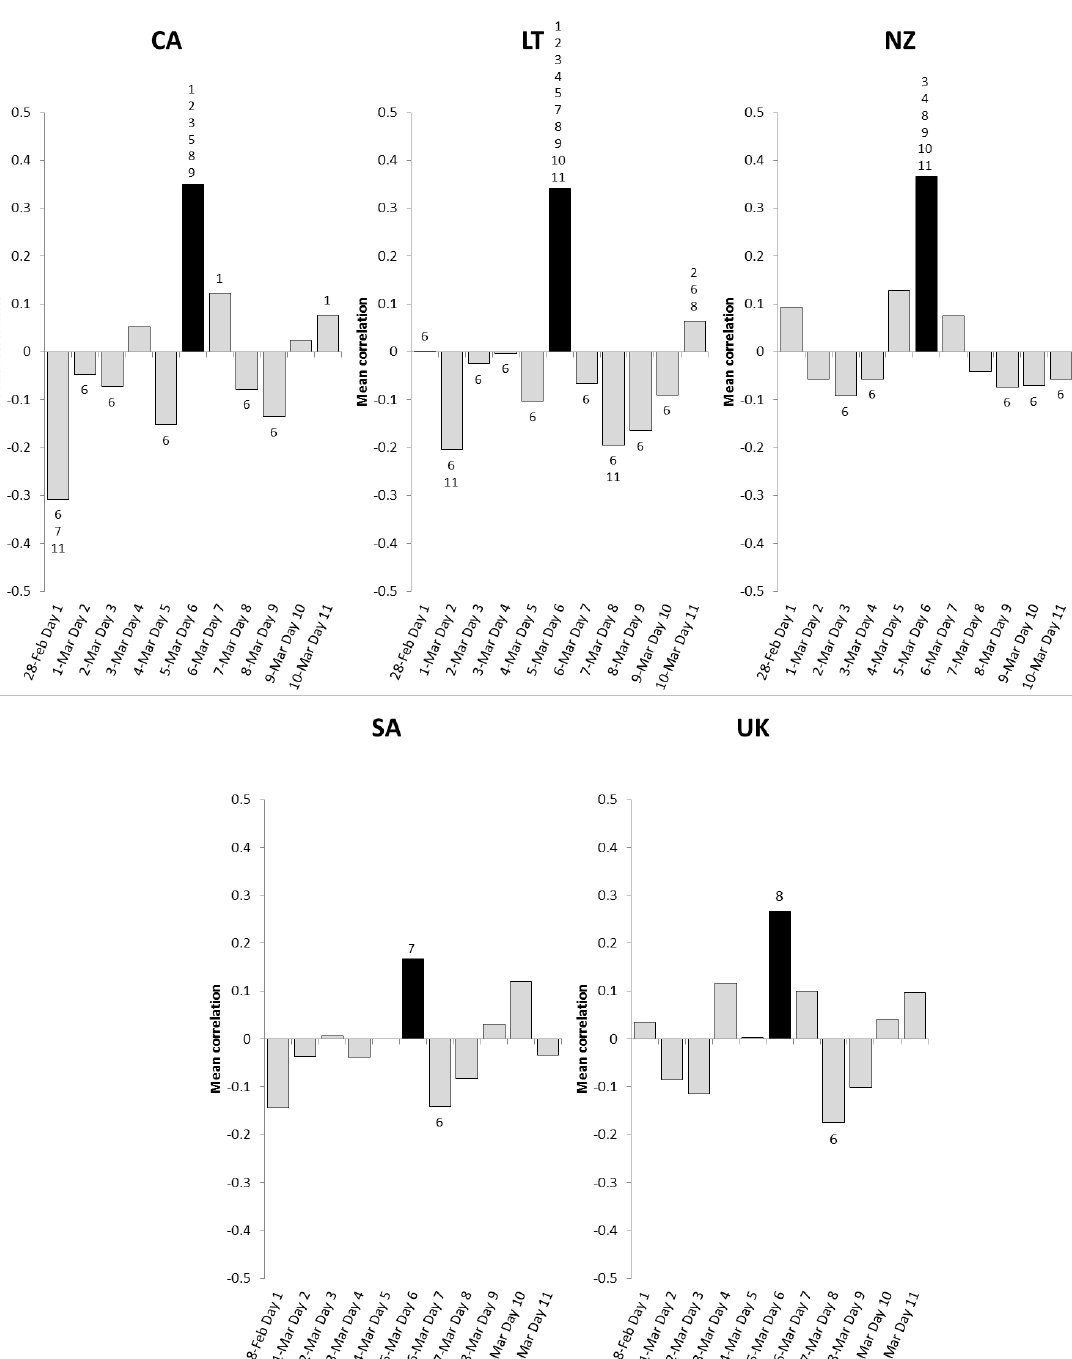
Figure 3. Mean LMF-HRV-correlation by Day and group.The day with the black color indicates day 6 which is the day all the groups did the 15-min Heart Lock-In at the same time. Pairwise significance is noted by Day# labels above each bar. It can be seen, for example, that in the Lithuanian group, day 6 (HLI day) was significantly different from all other days in the study period. Day 11 was different from three of the other days (2, 6 and 8),